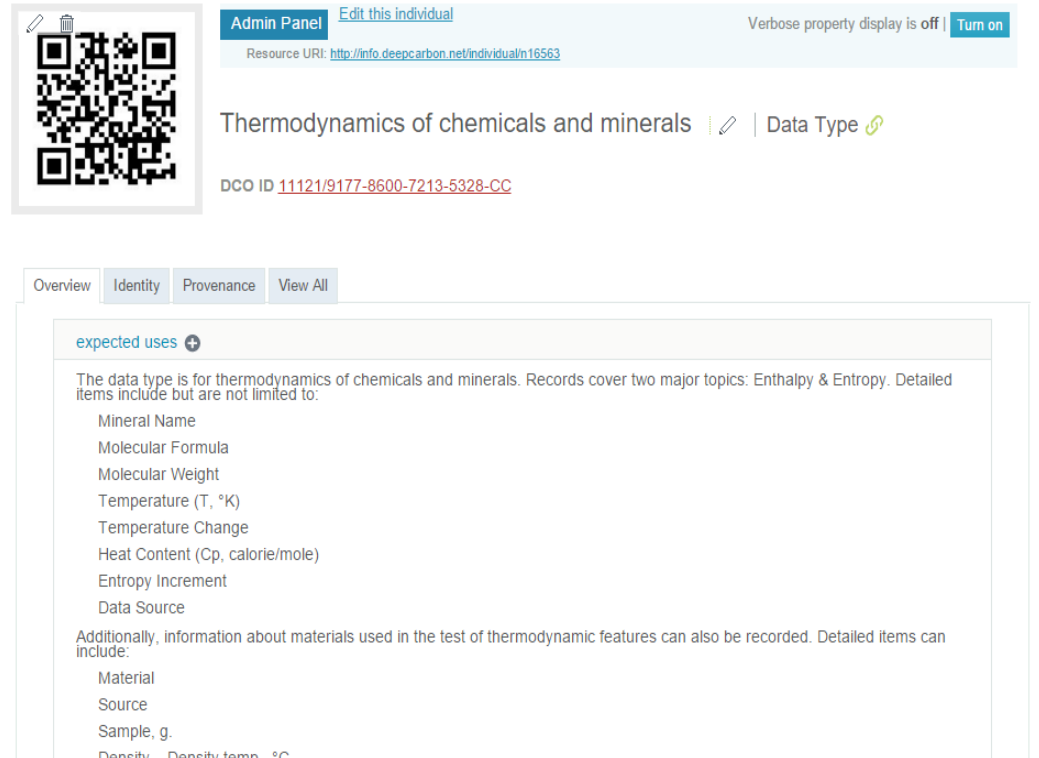
Figure 2. Screenshot of the profile of a registered data type.